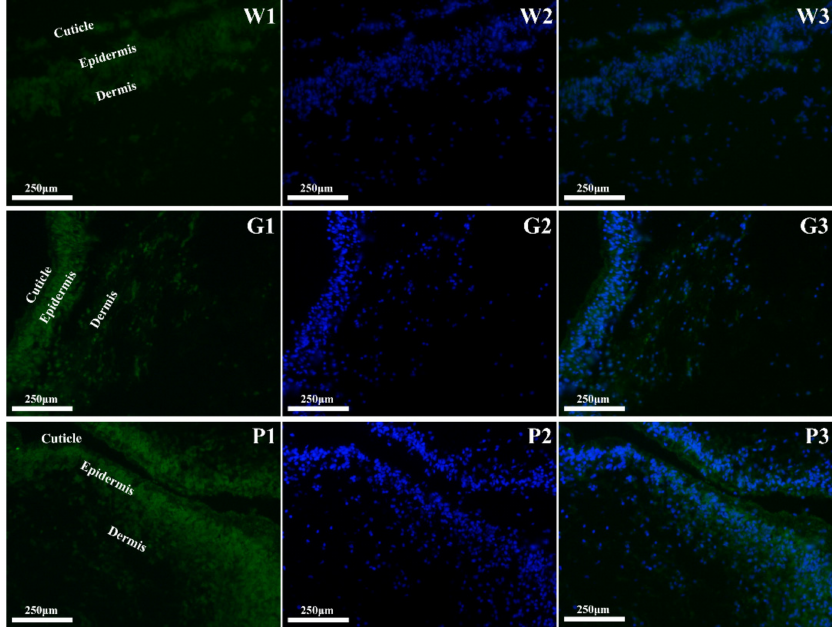
Figure 2. Fluorescence in situ hybridization analysis for MITF in the body wall of white, green, and purple A. japonicus . W1: hybridization signals of MITF in white A. japonicus ; W2: negative control with nuclear dye DAPI in white A. japonicus ; W3: merged signals in white A. japonicus ; G1: hybridization signals of MITF in green A. japonicus ; G2: negative control with nuclear dye DAPI in green A. japonicus ; G3: merged signals in green A. japonicus ; P1: hybridization signals of MITF in purple A. japonicus ; P2: negative control with nuclear dye DAPI in purple A. japonicus ; P3: merged signals in purple A. japonicus .